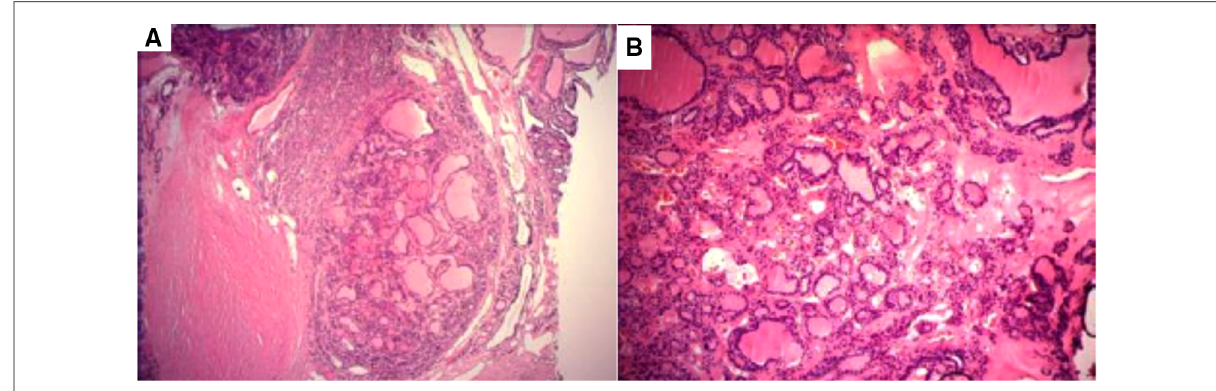
FIGURE 4 Histopathological images of the resected thyroid specimen. ( A ) Adenomatous nodular goiter with cystic changes (magni fi cation 40×). ( B ) Some thyroid follicular epithelial cells with papillary hyperplasia (magni fi cation